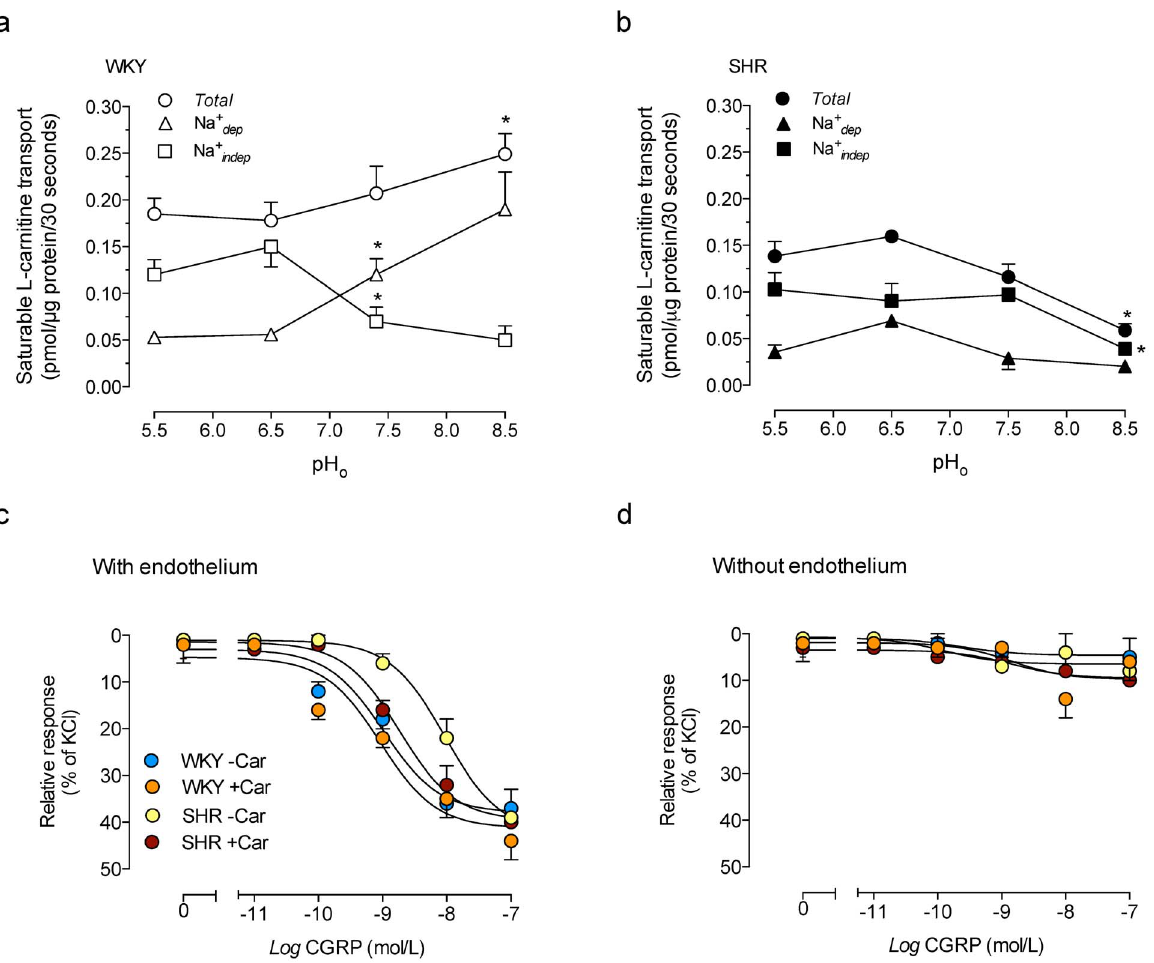
Figure 6. Effect of extracellular pH on saturable transport of L-carnitine, and rat aorta reactivity. Total saturable transport of L-carnitine ( Total ), and the Na + -dependent (Na + dep ) and Na + -independent (Na + indep ) transport components (20 m mol/L L-carnitine, 3 m Ci/mL L-[ 3 H]carnitine, 30 seconds, 37 u C) in RAECs cultures from WKY rats (a) or SHR (b) exposed to culture medium with the pH adjusted to different values. (c) Relaxation of 32.5 mmol/L KCl preconstricted endothelium-intact aortic vessel rings (With endothelium) from WKY rats or SHR in response to increasing concentrations of calcitonine gene related peptide (CGRP, 5 minutes), in the absence (-Car) or presence ( + Car) of 20 m mol/L L-carnitine (30 minutes). (d) Relaxation of endothelium-denuded aortic vessel rings (Without endothelium) to CGRP as in (c). * P , 0.05 versus all other values for the corresponding components. Values are mean 6 SEM (n=4–10).